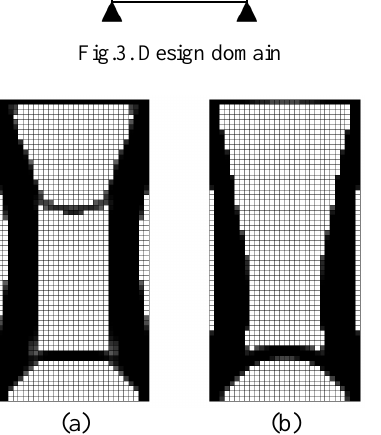
Fig.3. Design domain